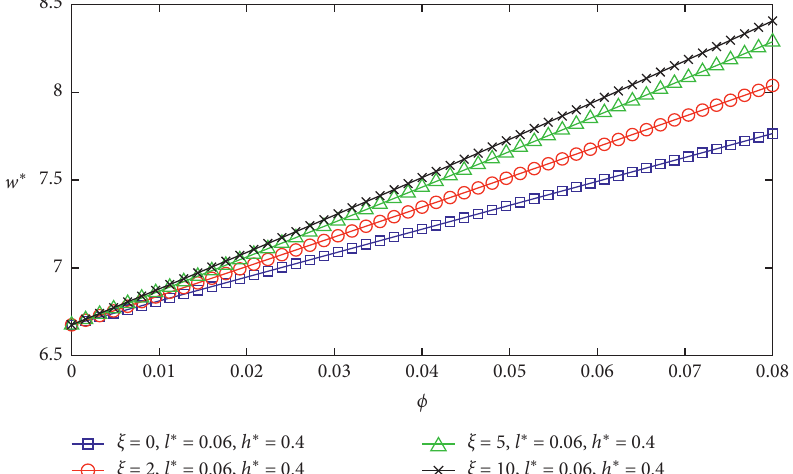
Figure 4: Variations of dimensionless load capacity versus volume concentration Φ for different values of ξ at l ∗ � 0.06 and h ∗ �